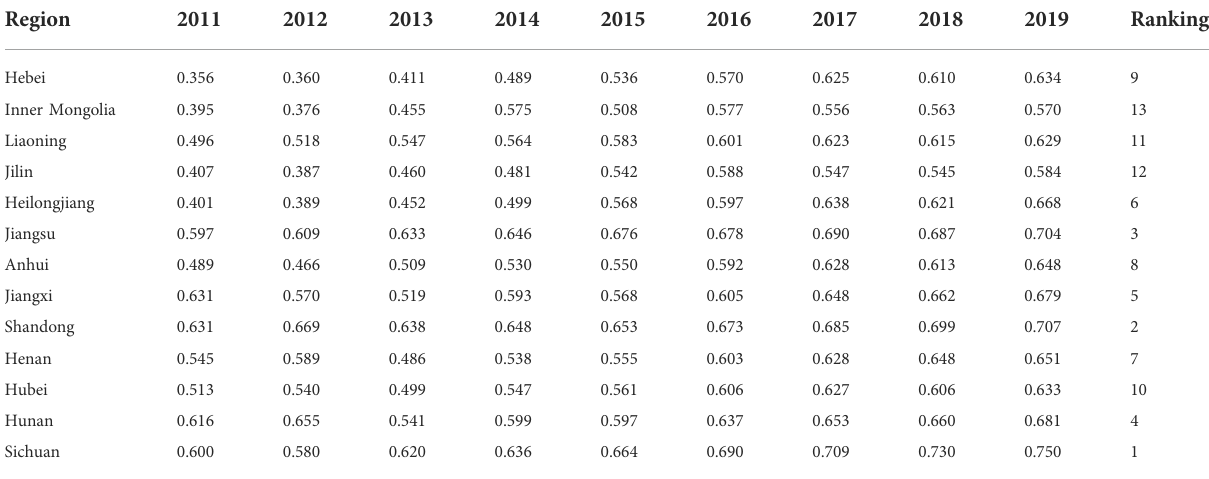
TABLE 5 Calculation results of environmental index. Region